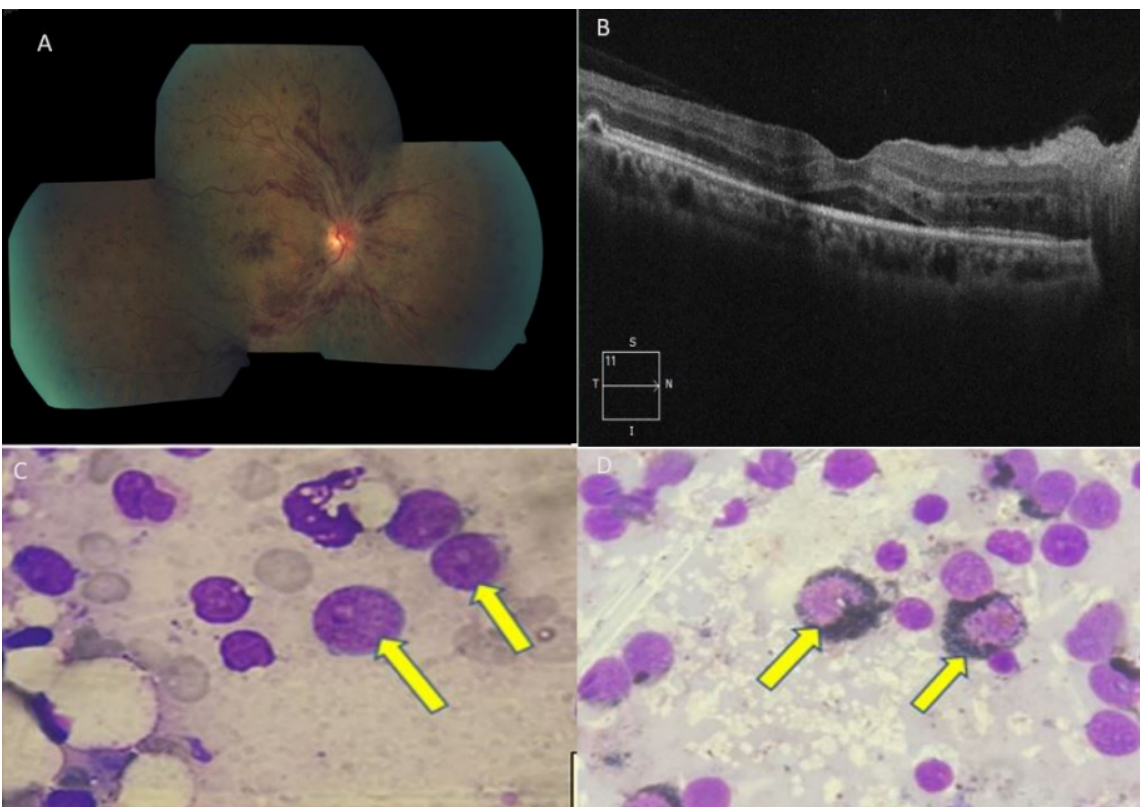
Figure 1: A) Fundus photo of the right eye showing dilated and tortuous retinal veins, optic disc edema and multiple flame-shaped, deep retinal hemorrhages involving posterior pole extending onto the retinal periphery suggestive of central retinal vein occlusion. B) Spectral domain optical coherence tomography (SD-OCT) of the same eye revealing subretinal fluid in the foveal region suggestive of cystoid macular edema. C) Bone marrow aspirate showing blasts, Leishman Giemsa stain, x1000 (yellow arrows). D) Blast cells showing myeloperoxidase (MPO) positivity (yellow arrows) with MPO stain, x1000 diagnostic of acute